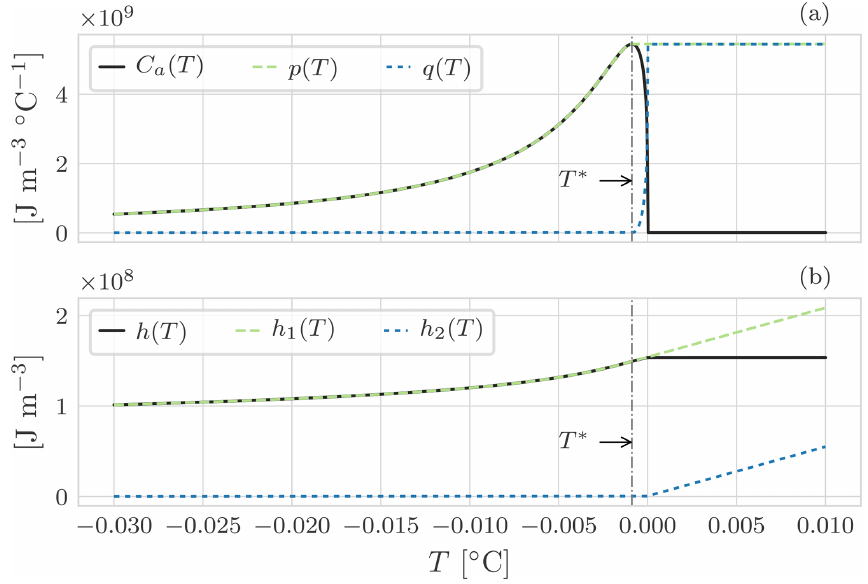
Figure 1. Graphical representation of the Jordan decomposition for the enthalpy of soil using the SFCC model for a silty soil (Dall’Amico, 2010). Panel (a) shows the Jordan decomposition of C a (T ) , Eq. (18). For T = T ∗ , C a (T ) presents a maximum: for T < T ∗ it is increasing, and for T > T ∗ it is decreasing. This non-monotonic behaviour causes problems when solving the non-linear system. C a (T ) is thus replaced by p(T ) and q(T ) , two monotonic functions. Consequently, in panel (b) , h(T ) is replaced by h 1 (T ) and h 2 (T ) , Eq. (19).